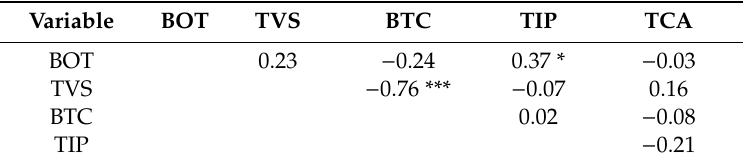
Table 3. Correlations between bleeding out times, total blood loss at sticking, total blood volume in the chest cavity, time to lose sensibility, and time to cardiac arrest.